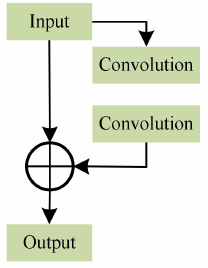
Figure 6. The structure of the residual